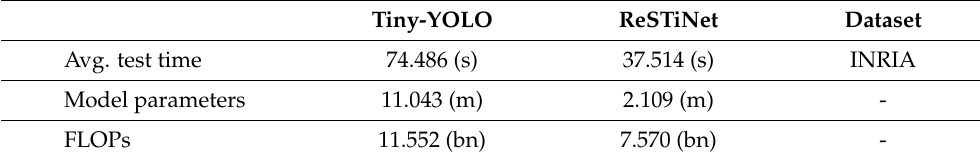
Table 4. Detection time, parameter, and FLOP comparison.